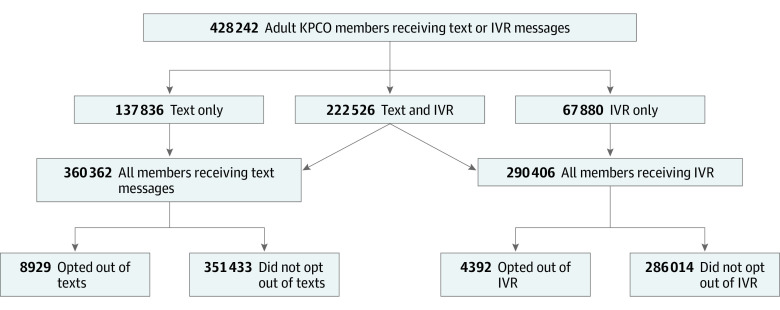
Study Cohort and Analytic SubgroupsKPCO indicates Kaiser Permanente Colorado; IVR, interactive voice response.